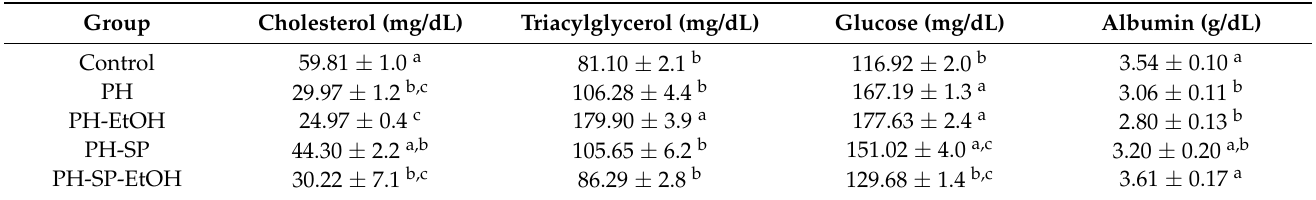
Table 3. Serum metabolites in the control group and partial hepatectomy, ethanol, and Spirulina (formerly Arthrospira)-treated animals.